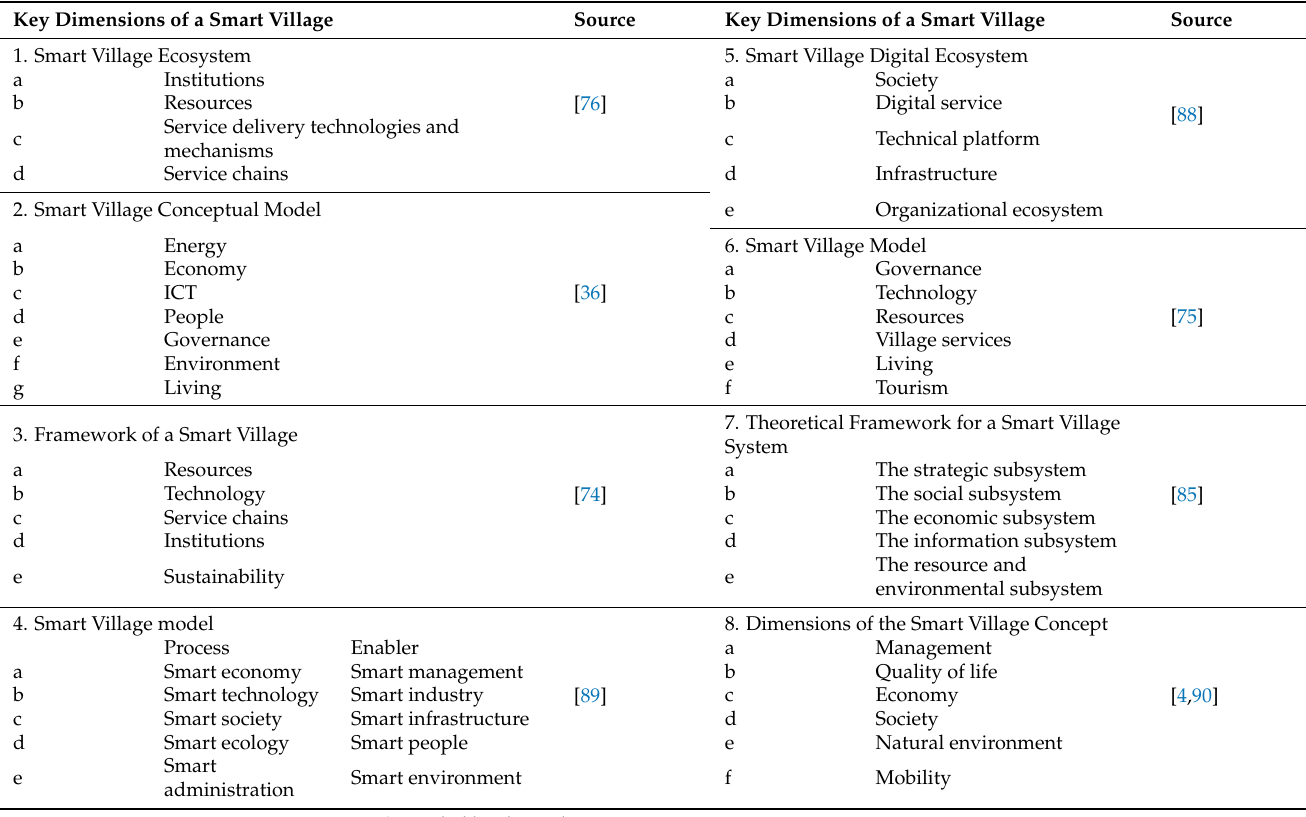
Table 2. Current global initiatives and regional or national agendas related to smart